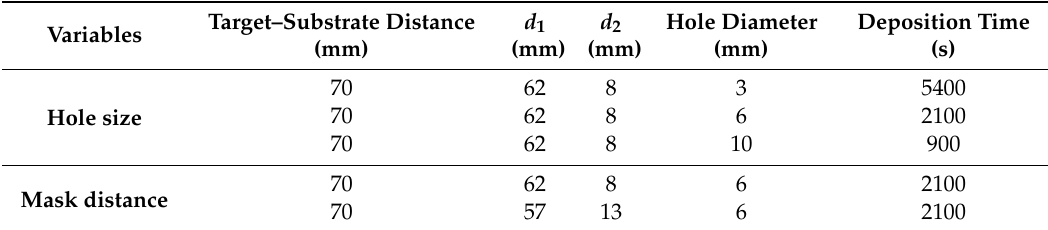
Table 1. Detailed experimental parameters. The hole size on the mask and the distance of the mask between the target and the substrate are two variables.